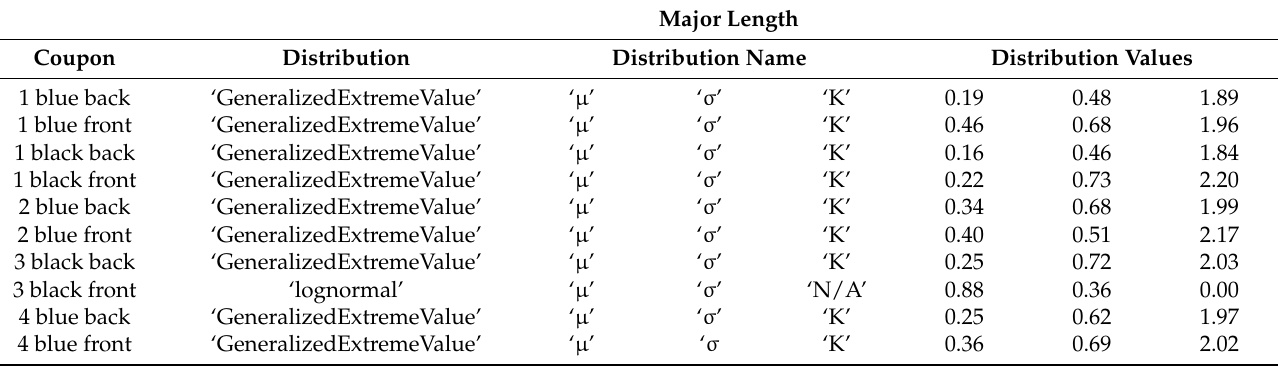
Table 4. Major length statistical fit.